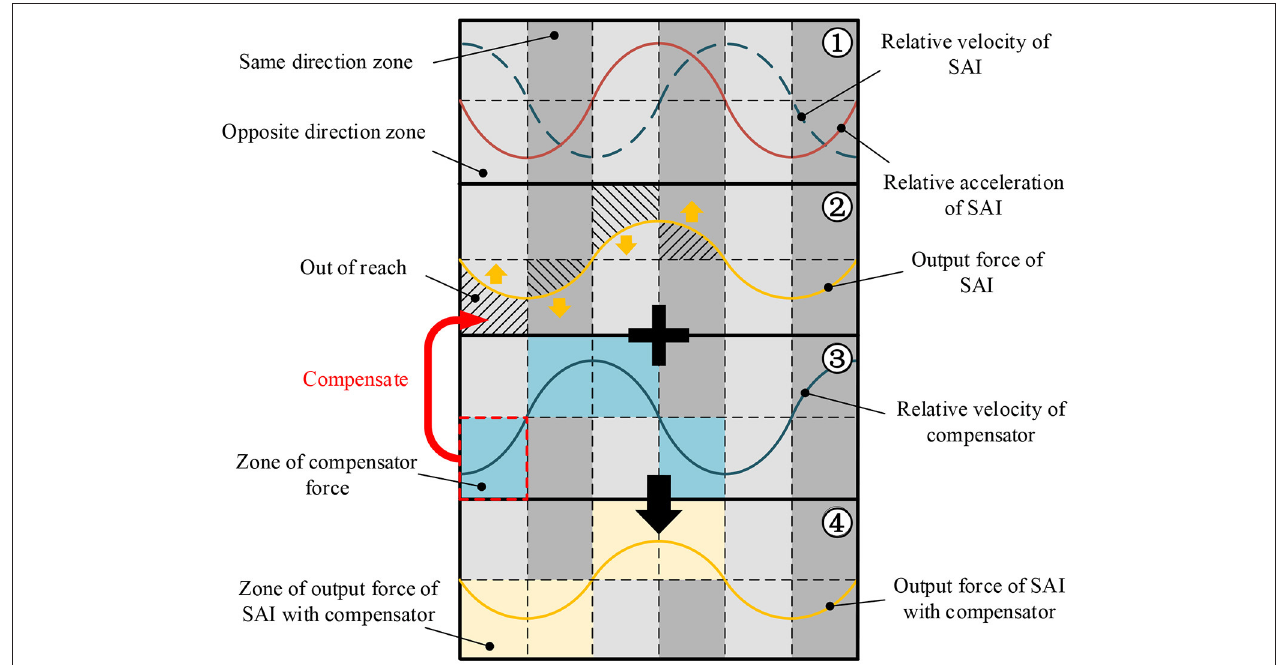
FIGURE 11 | Adjustment principle of the equivalent inertance.